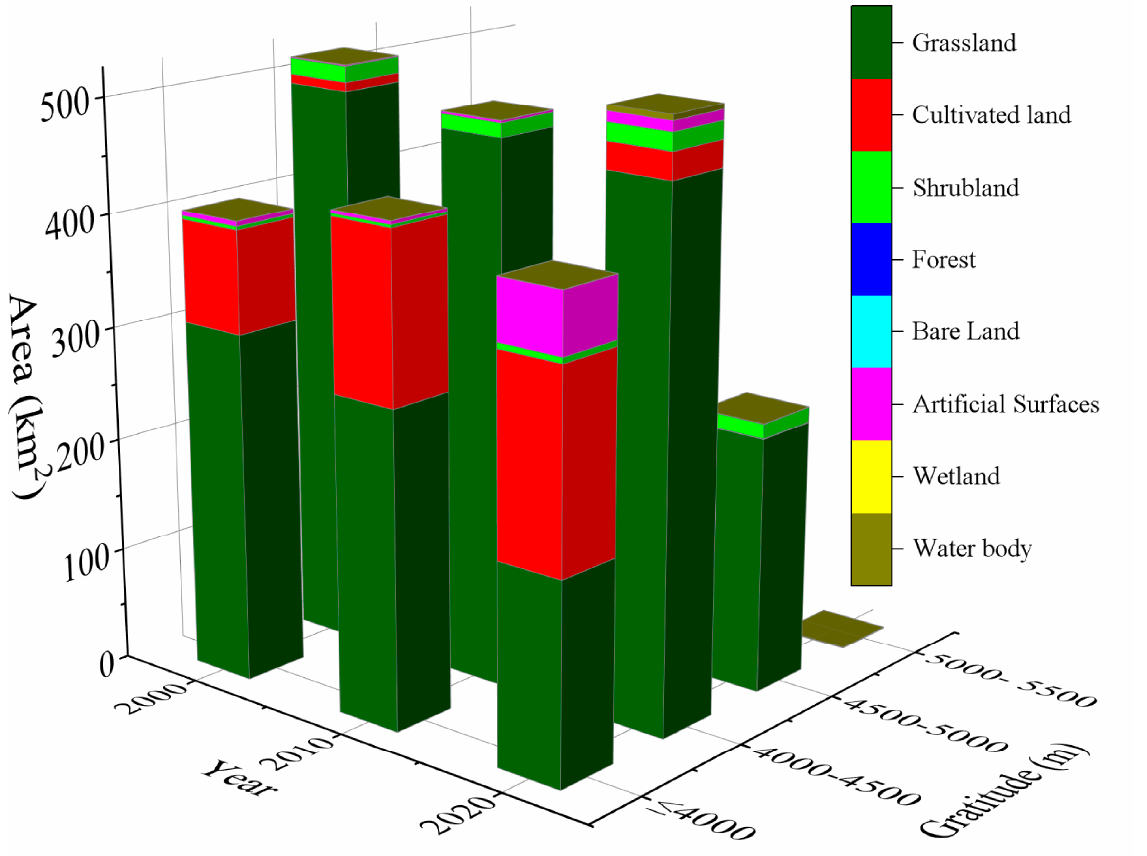
Figure 5. Area of land use/cover of alluvial fans at different altitude grades(km 2 ). Cultivated land was mainly distributed at an altitude ≤ 4000 m. Compared with 2000, the increased area of cultivated land at this altitude accounted for 115.56% and 83.92% of the total increased area in 2010 and 2020, respectively. In the areas at an altitude of 4000–4500 m, the distribution of cultivated land was only 7.78 km2 in 2000. By 2010, no cultivated land existed at this altitude, and by 2020, the decreased area accounted for 15.55% of the total increased area. In 2000 and 2010, no cultivated land was distributed at an altitude of 4500–5000 m, and by 2020, the area increased by 0.51 km 2